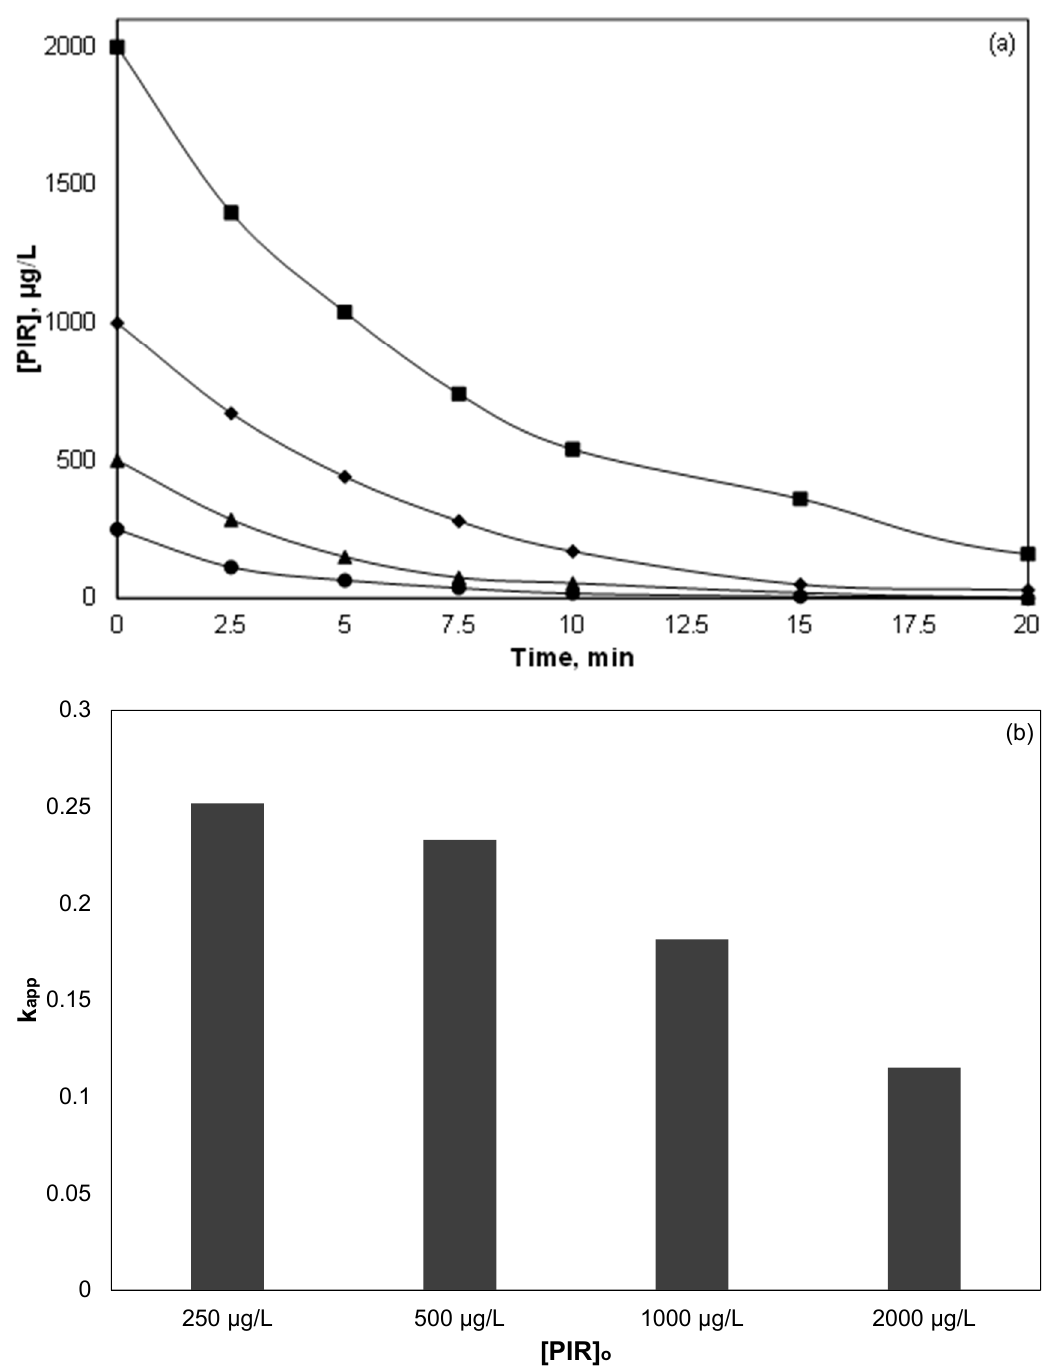
Figure 2. Effect of PIR initial concentration on its decomposition: ( a ) PIR concentration versus time; ( b ) apparent kinetic constant. [Fe 2+ ] = 2 mg/L, [SPS] = 20 mg/L, ultrapure water and inherent pH.